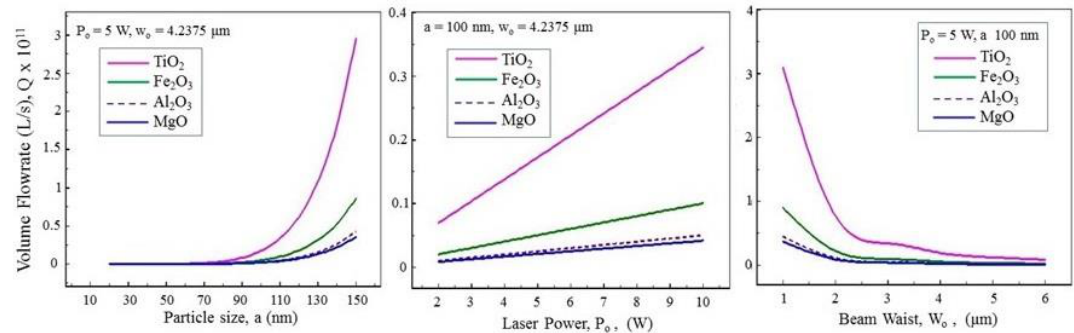
Figure 5. Effects of the laser power, P o , beam waist, W o , and particle size on the fluid volume flowrate (focal length = 75 mm, beam diameter d = 6 mm, λ = 532 nm, nm ( w o = 4.2375 μm, Equation (8)), refractive index of water n f = 1.332, water viscosity µ f =0.98 × 10 − 3 kg/m-s, the particle is at the beam waist).